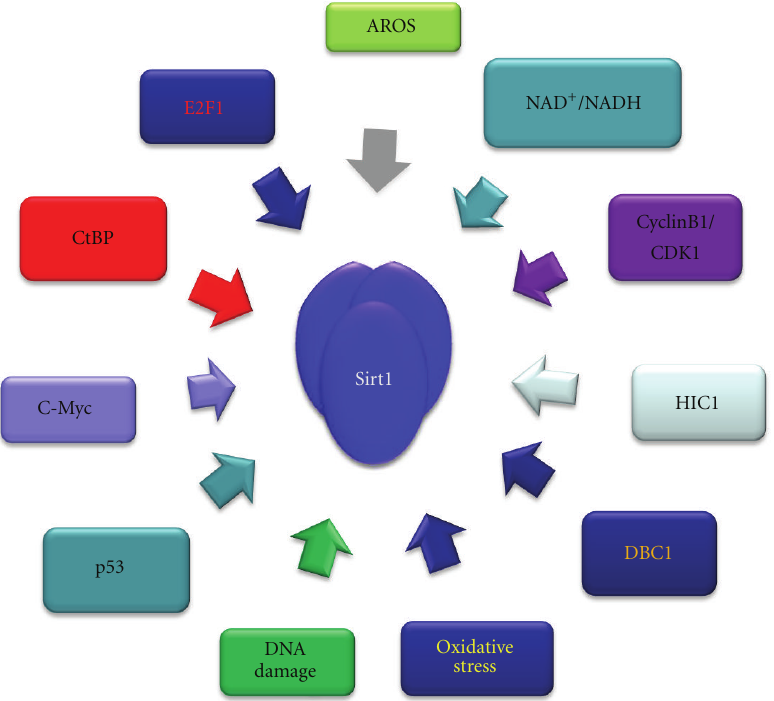
Figure 2: Factors involved in the regulation of Sirt1 gene expression and enzymatic